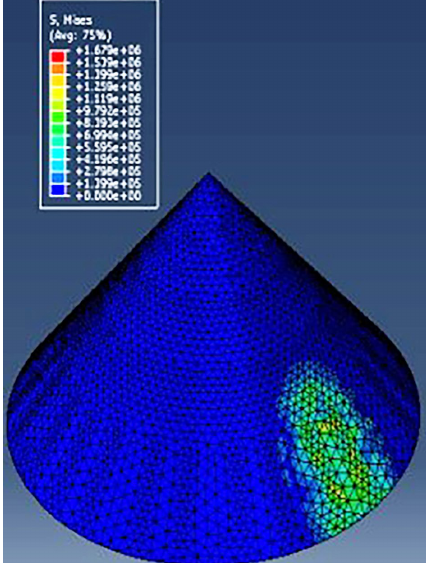
Fig. 16. Von misses composite stress contour in the conical building in a moment after explosion strikes building in 10 meters high from the